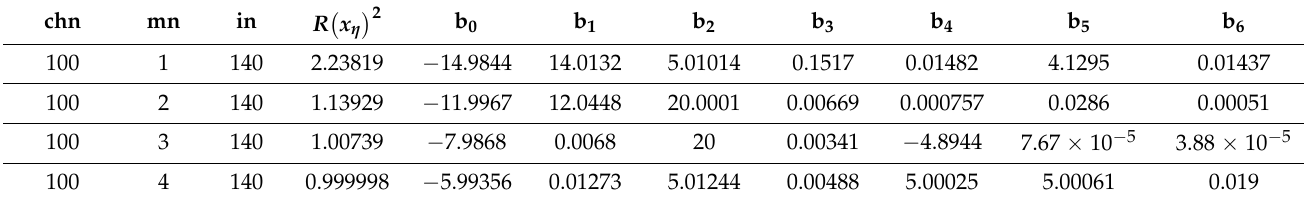
Table 4. Multiple determination coefficients obtained for the best regression coefficients (b 0 , b 1 , . . . , b 6 ) in the computer simulation described by {chn, mn, in =